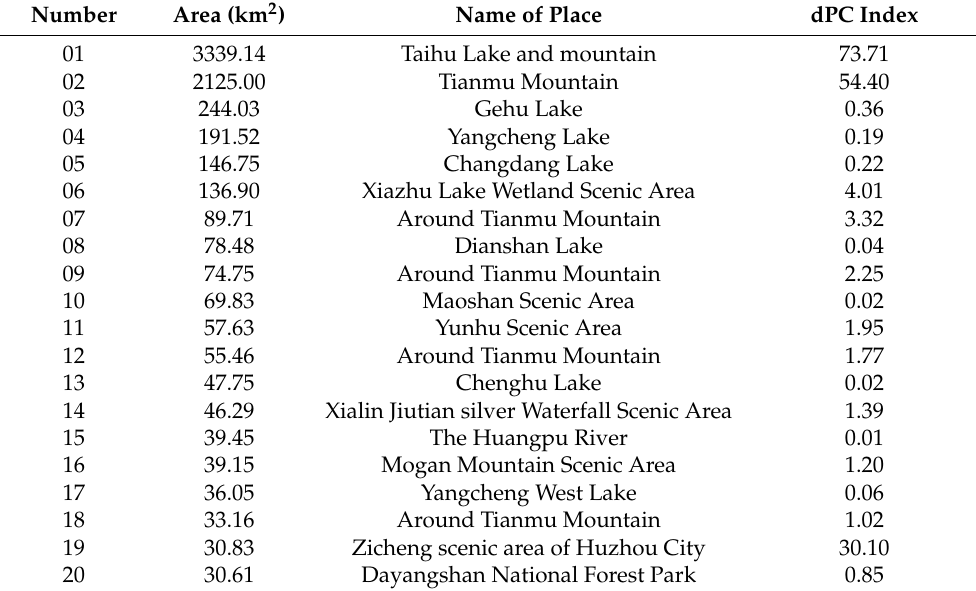
Table 5. Ecological source importance index